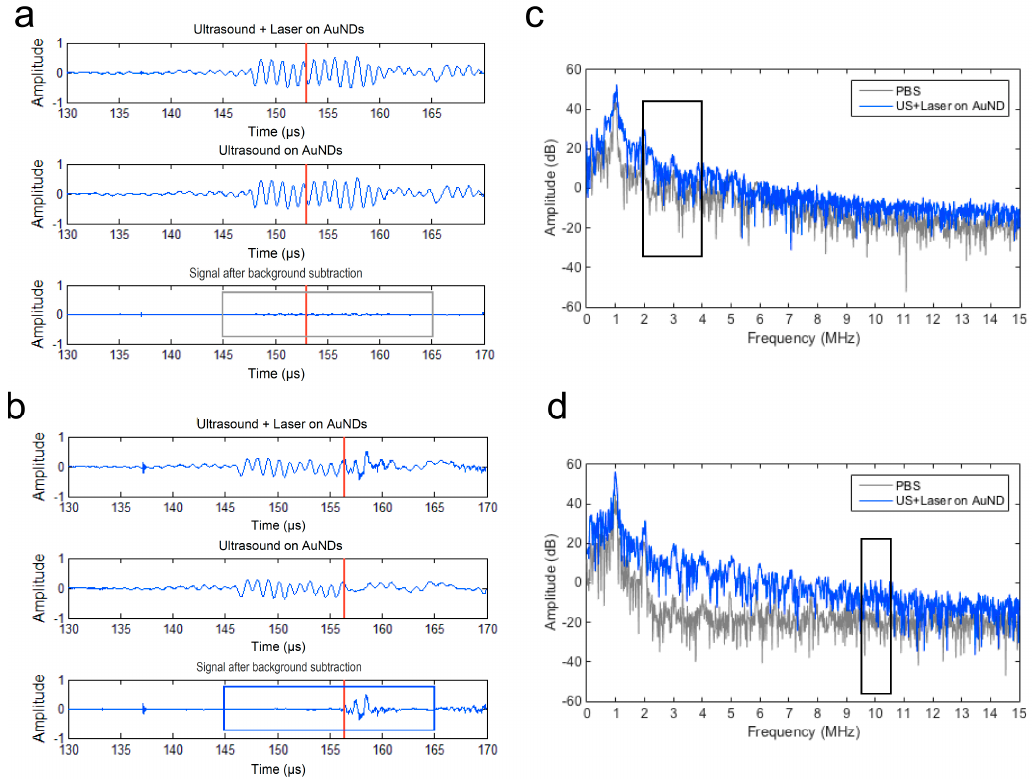
Figure 3. Scatter signal detection of vaporization and cavitation events using a 5 MHz unfocused transducer and a 10 MHz focused transducer. The red line denotes the lasing time. The background signal was detected using ultrasound only. ( a ) No vaporization and cavitation event was detected. ( b ) Vaporization and cavitation events were detected. ( c ) Spectra of the received vaporization signals shown in the gray box in (a) and the blue box in (b). ( d ) Spectra of the received cavitation signals shown in the gray box in (a) and the blue box in (b). Black boxes in (c) and (d) denote the range of the spectra for root-mean-square (RMS) amplitude calculations.